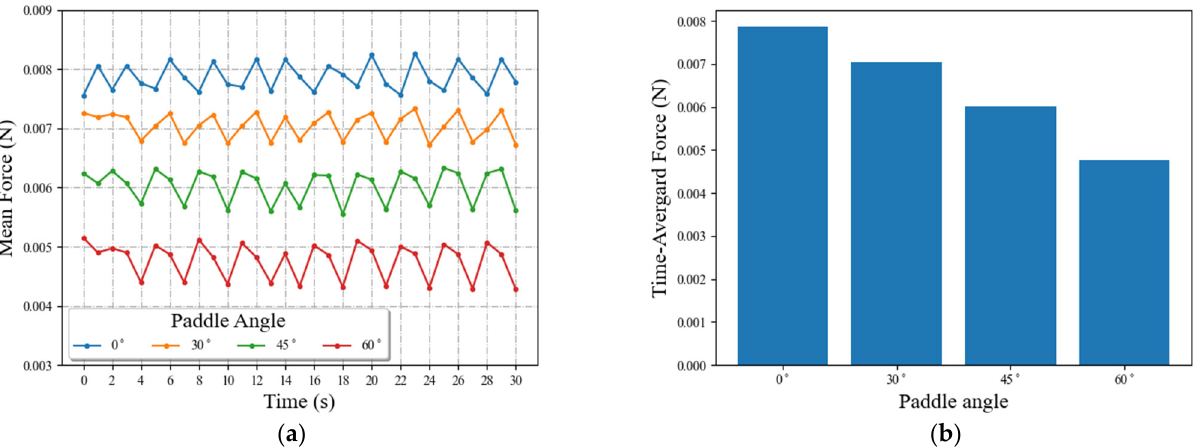
Figure 14. Force acting on the particles in various paddle angles; ( a ) mean force, and ( b ) time- averaged force.